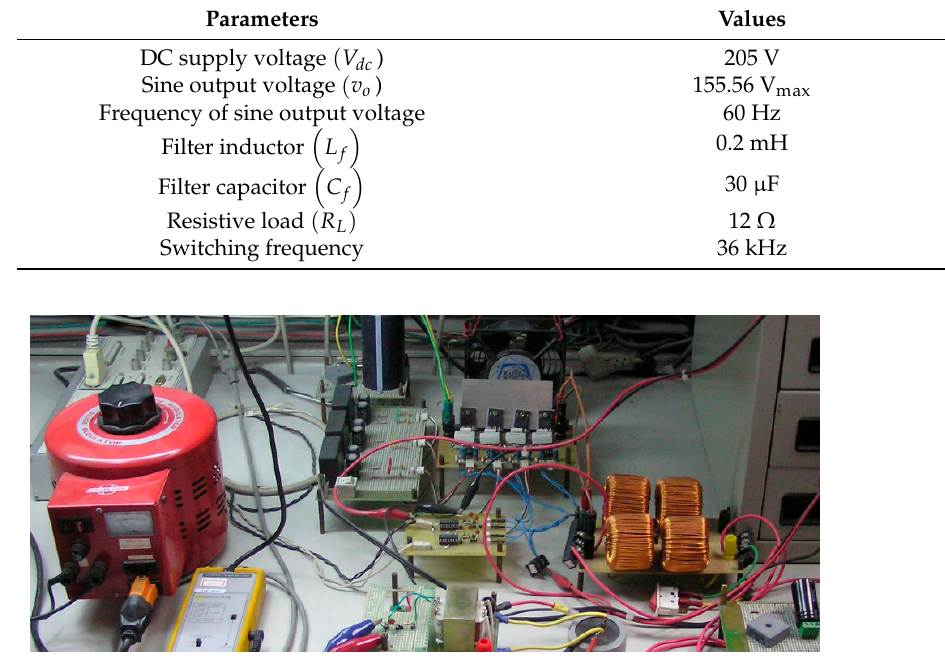
Figure 2. Prototype picture of a single ‐ phase sine ‐ wave inverter. Table 1. Parameters of the sine ‐ wave inverter with inductor ‐ capacitor filter.